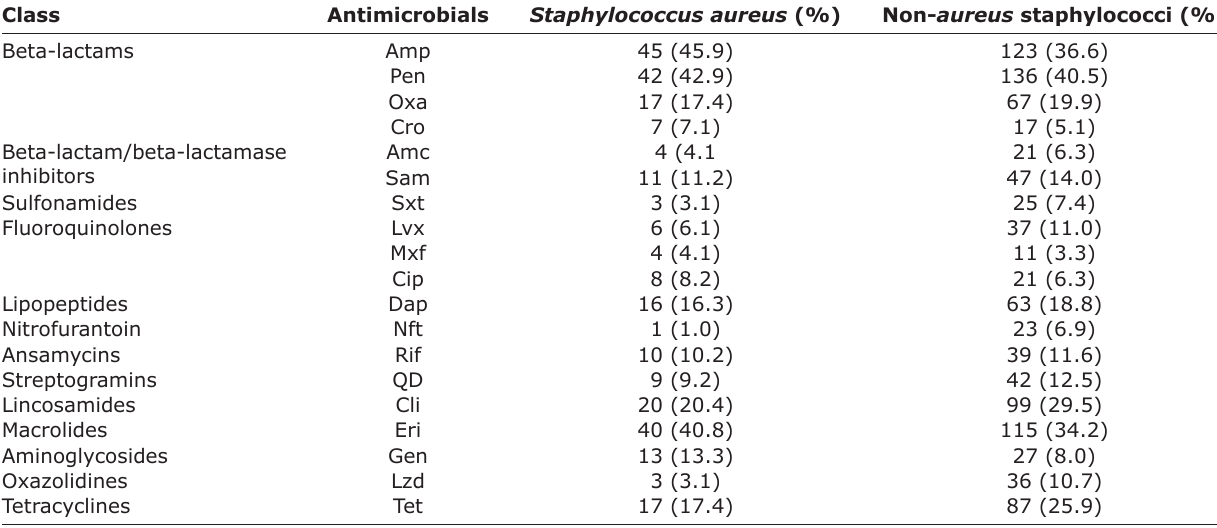
Table-2: Antimicrobial susceptibility profiles of Staphylococcus aureus and non- aureus staphylococci isolated from goat milk in Paraiba State, Northeast Brazil. Class